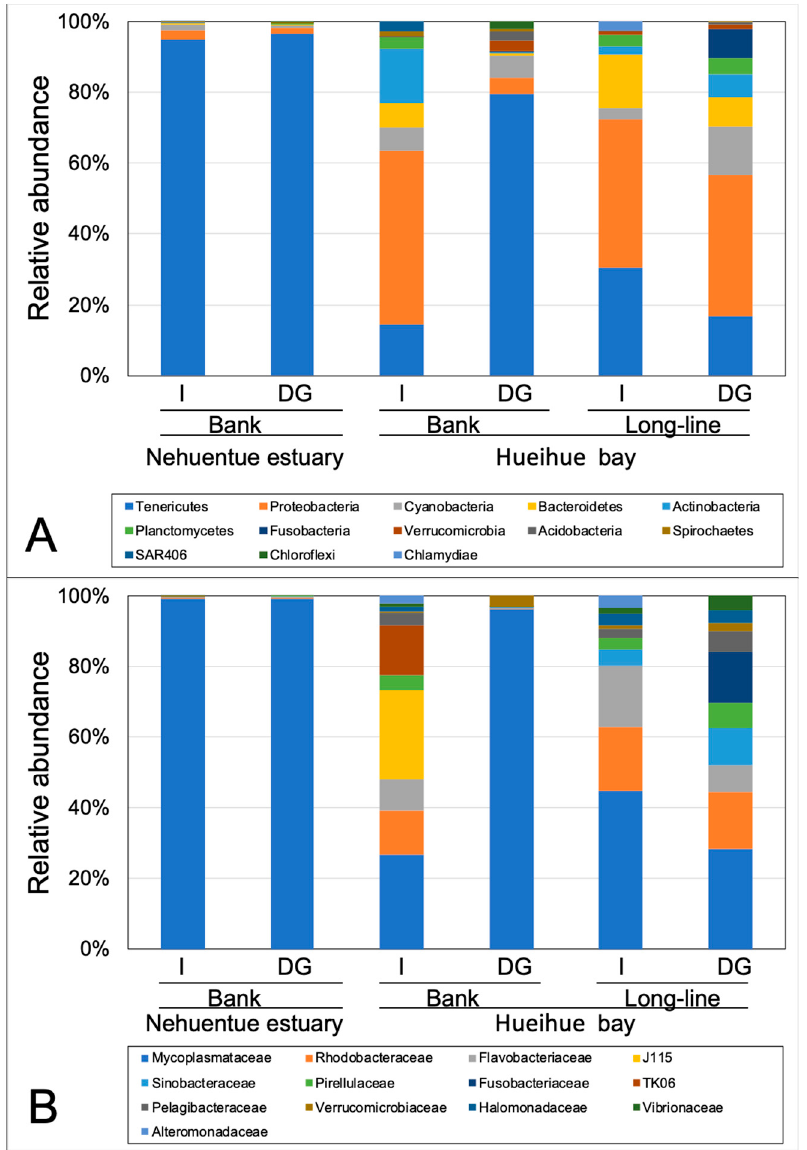
Figure 2. Mean relative abundances ( n = 3) of taxa at the phylum ( A ) and family ( B ) levels of bacterial communities in intestines (I) and digestive glands (DG) in tissue samples of Choromytilus chorus specimens grown in natural bank from Nehuentue Estuary, and natural bank and long–line system from Hueihue Bay.